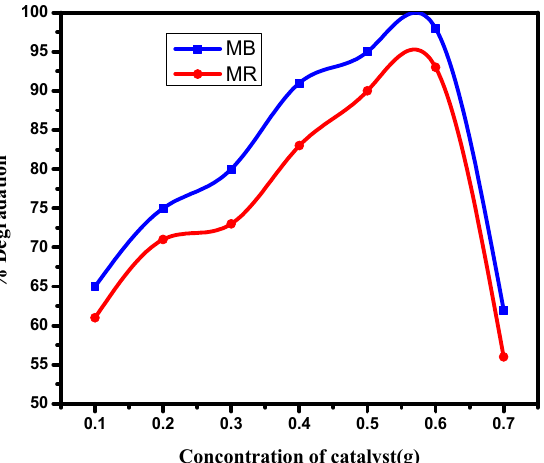
Figure 13. Influence of catalyst dosage on the degradation of methylene blue and methyl red dye in an aqueous system.